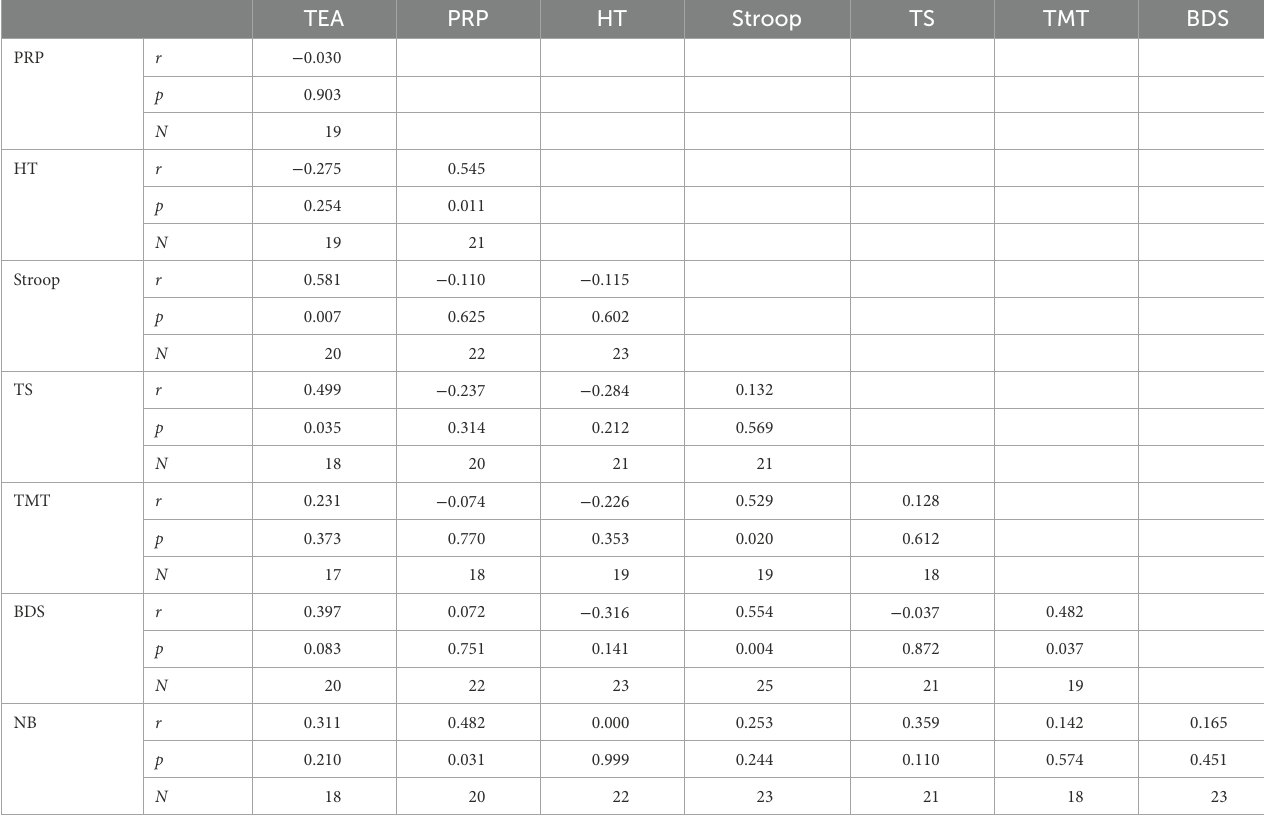
TABLE 6 Older adults correlation matrix of the average executive function z-score measures. TEA PRP